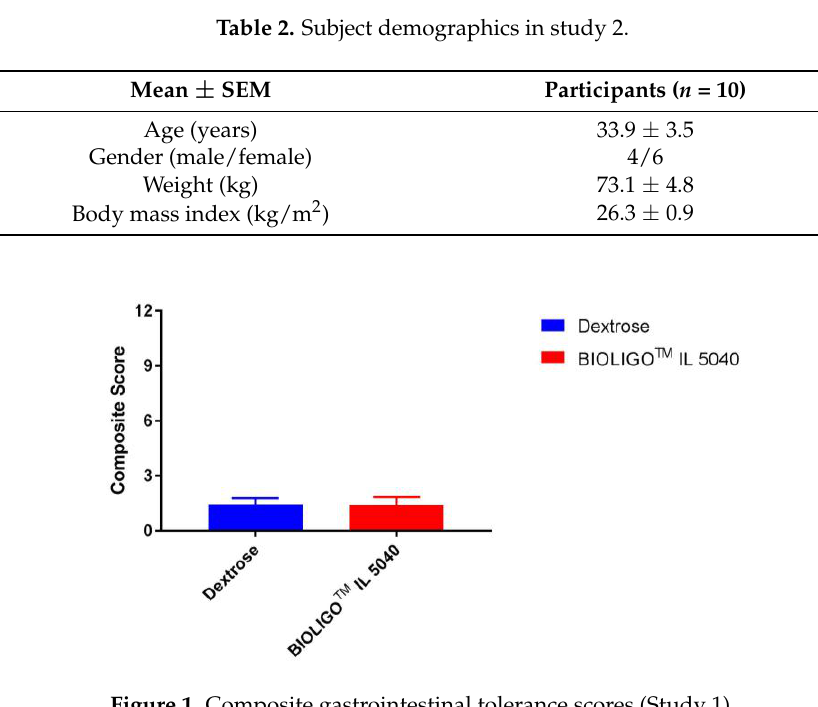
Table 2. Subject demographics in study 2.